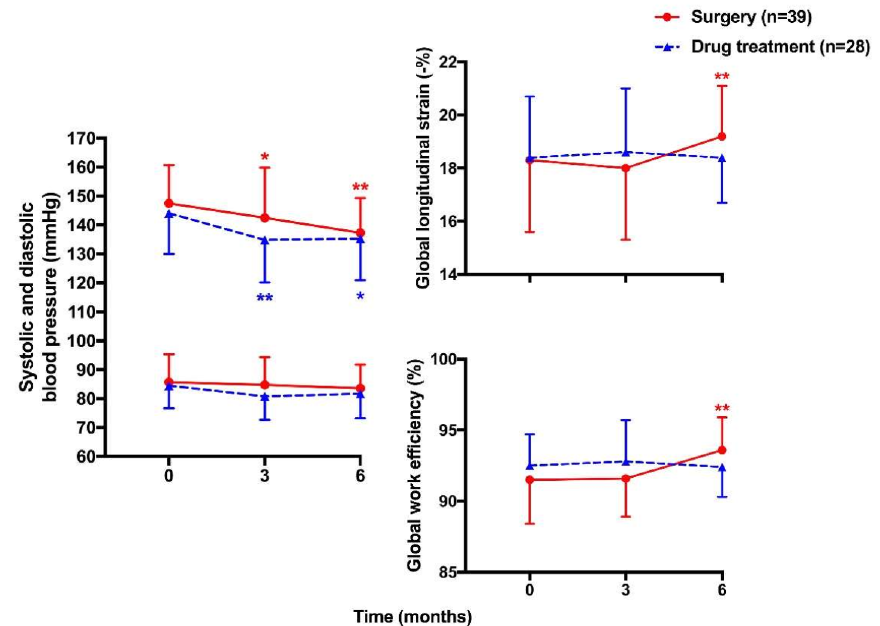
Figure 5. Mean ( ± SD) values of systolic ( upper left lines ) and diastolic blood pressure ( lower left lines ) and global longitudinal strain ( upper right ) and global work efficiency ( lower right ) of the left ventricle at baseline and during follow-up in patients treated with surgery (circles with solid lines) and drugs (triangles with dashed lines). * p < 0.05, ** p < 0.01 vs. baseline. Reproduced from Chen YL, et al.